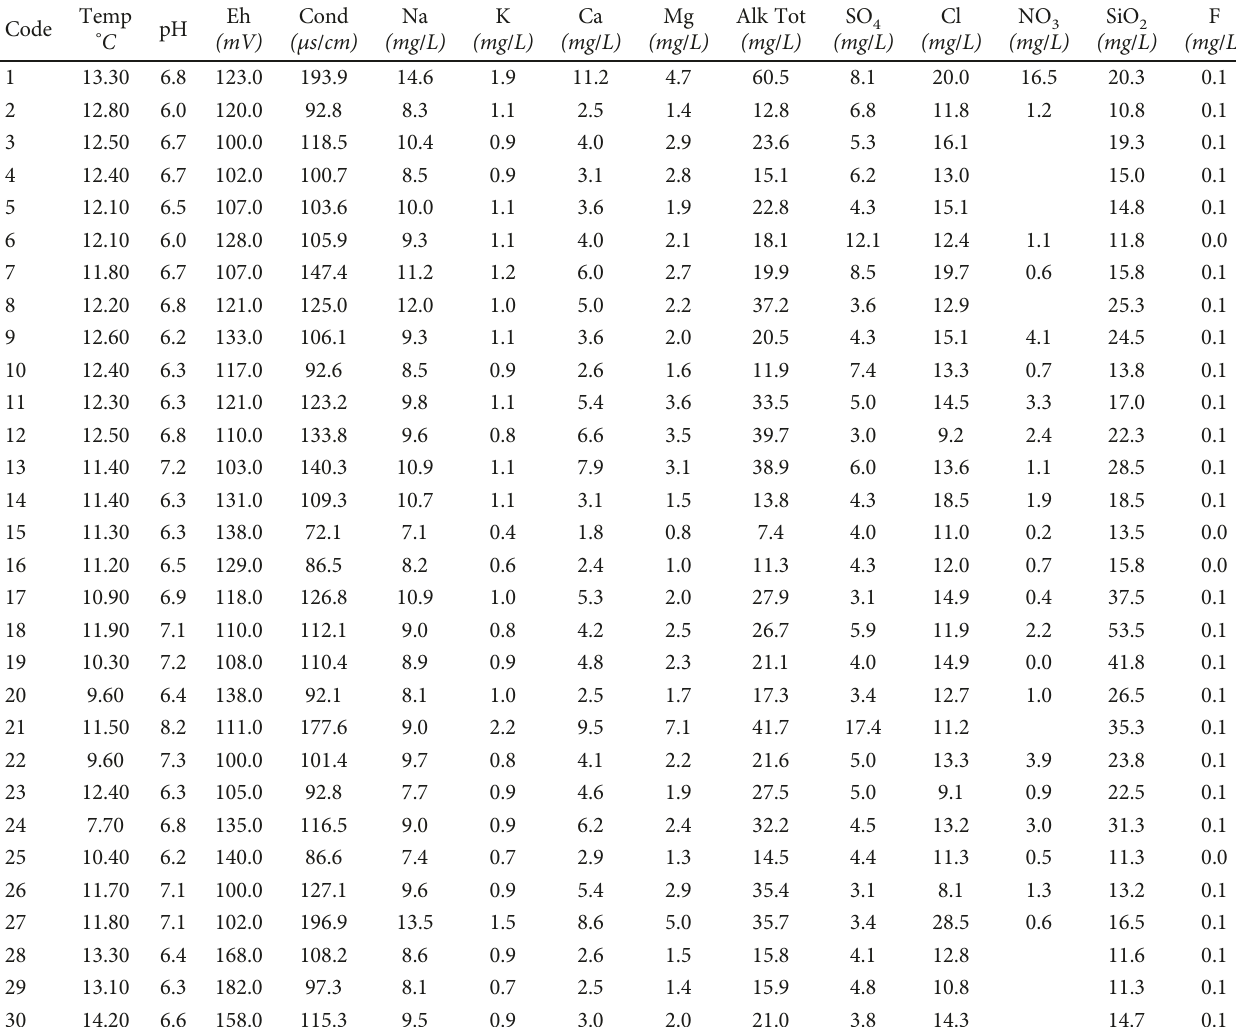
Table 1: Chemical-physical parameters of groundwater samples coming from the study. Code